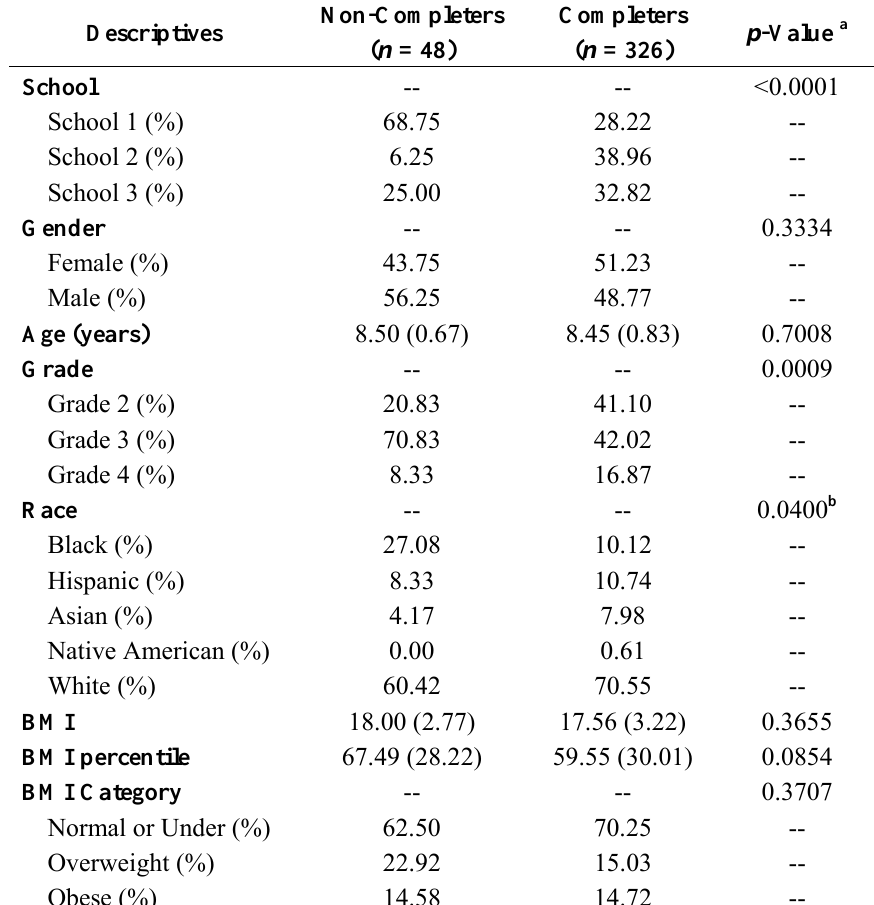
Table 3. Baseline characteristics comparing students who completed the physical measurement in the Fall and Spring (completers) with students who dropped out from the study or changed the treatment (non-completers), expressed in means (standard deviation) or